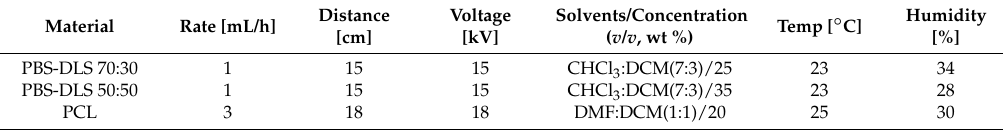
Table 1. Electrospinning conditions for PCL, PBS-DLS 70:30 and PBS-DLS 50:50 copolymers.